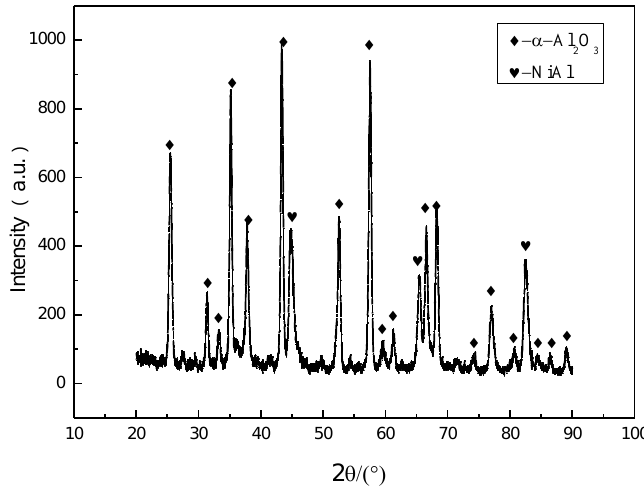
Figure 8. XRD pattern of NiAl intermetallic coating after oxidation testing at 1073 K for 100 h (10 cycles).